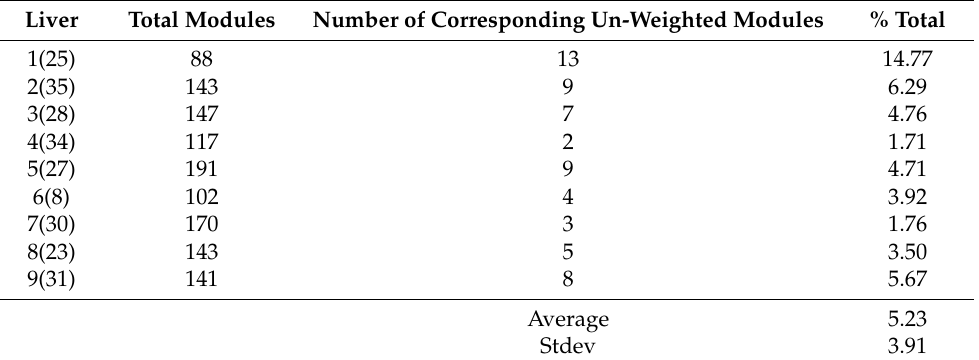
Table 4. For each liver, the number of modules that satisfy the baseline criteria based on edge-weighted network partitioning is listed along with the number of modules that have a corresponding module in the un-weighted partition with the same reaction nodes.